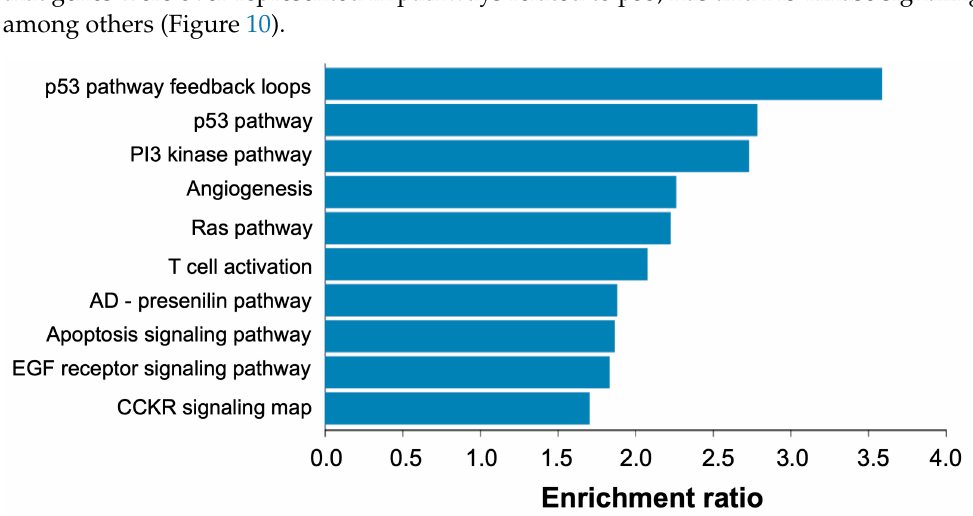
Table 3. List of 472 proteins related to ovarian cancer with the protein–protein interaction-networks